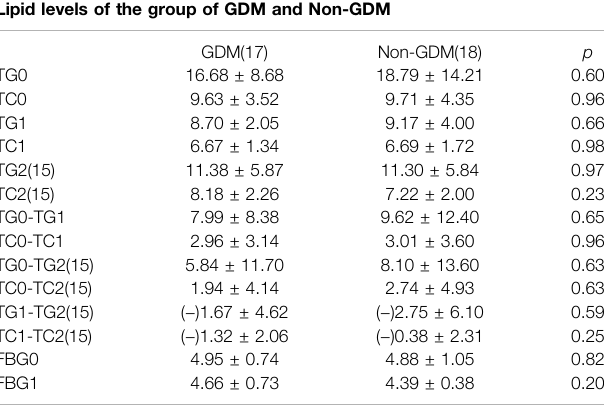
TABLE 2 | Lipid levels of the group of GDM and Non-GDM. Lipid levels of the group of GDM and Non-GDM